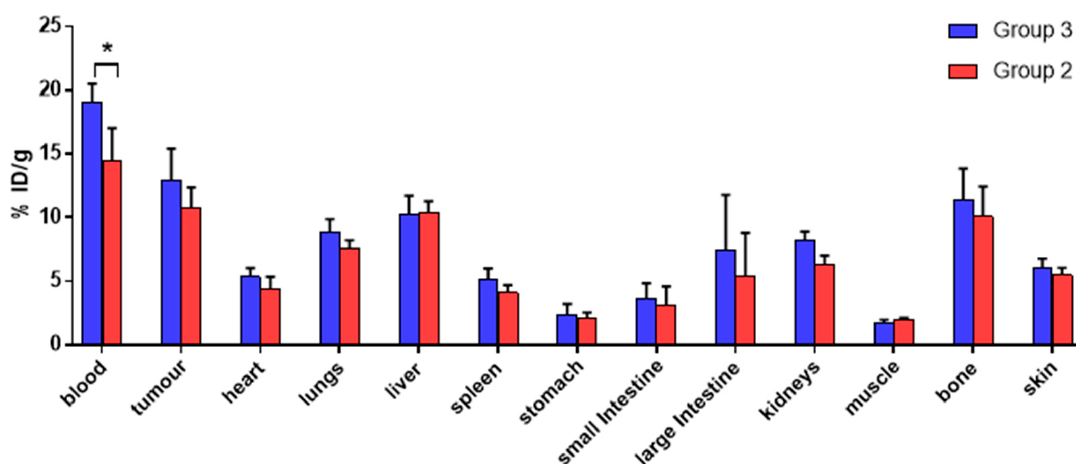
Figure 5. Ex vivo 68 Ga biodistribution in nude mice bearing SW1222 xenografts at 3 h after 68 Ga injection, comparing mice pretreated with THP Me -NCS-huA33 (group 2) 24 h before 68 Ga injection (red), with mice that were not pretreated with any immunoconjugate (group 3, blue). For each group n = 5, data are presented as mean ± SD. Comparison between the two groups was performed by a two-tailed t -test for each organ (* p < 0.05). As in vivo radiolabelling efficacy is expected to be highly dependent on local accessible chelator concentration, we hypothesised that failure to observe a pretargeting effect could be explained by insufficient local concentration of the chelator on the tumour surface. Therefore, in a second attempt at pretargeting we repeated the immunoconjugation with higher molar equivalents of chelator, aiming to increase the average chelator/antibody ratio of the conjugate and, hence, the concentration of chelator available at the tumour cell surface for in vivo radiolabelling. A first attempt at antibody- chelator conjugation using 50 molar equivalents of chelators resulted in precipitation of the